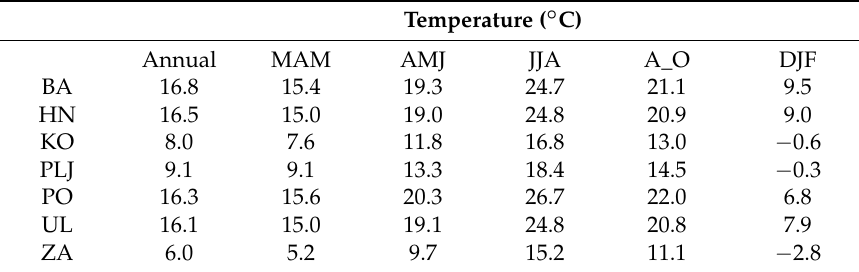
Table 7. The average temperature for 2001–2010.